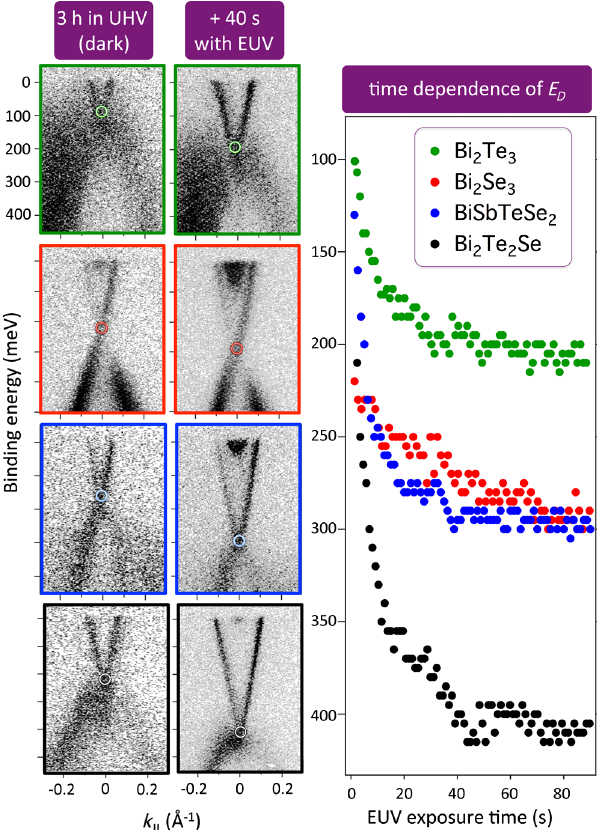
FIG. 2. The striking effect of illumination on the evolution of band bending during a typical ARPES experiment on TIs. Left- hand (center) columns of I ð E; k Þ images: Surface band struc- ture of four different TI compounds recorded using an EUV exposure of only 1 s (40 s), after the cleavage surface had been exposed to residual UHV gases for 3 h. Right-hand column: Very rapid evolution of E D from the first moment of EUV illumination, whereby the left-hand I ð E; k Þ images underlie the first (second for BiSbTeSe 2 ) data point of each curve in the right-hand panel. The pressure before and during the ARPES measurements was 1 . 0 × 10 − 10 and 5 . 0 × 10 − 11 mbar, respec- tively. All data have been acquired at 16 K using a photon flux of 3 . 2 × 10 21 photons = ð s m 2 Þ . The photon energy was 30 eV for Bi 2 Se 3 and 27 eV for all the other compounds.